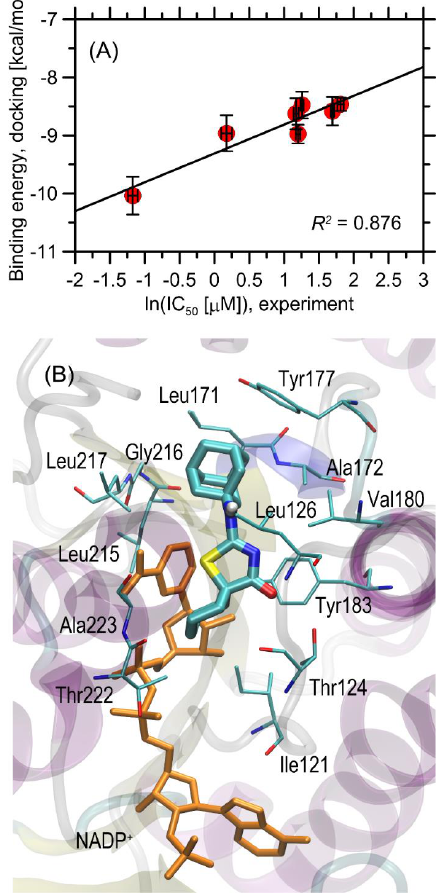
Figure 3. ( A ) The correlation between the binding energies calculated for 11β -HSD1 protein inter- acting with a set of ligand molecules with the experimentally inferred IC 50 values. The numerical values can be found in Table 2. ( B ) The energetically favorable location of the 3i ligand molecule bound to the 11β -HSD1 (pdb:3czr) structure. The ligand molecule is shown as thick sticks, whereas all the closest amino-acid residues (<0.38 nm) are represented by thin sticks. Orange sticks represent the NADP + molecule, also present in the protein crystal structure. The description of the interaction types is given in the text.